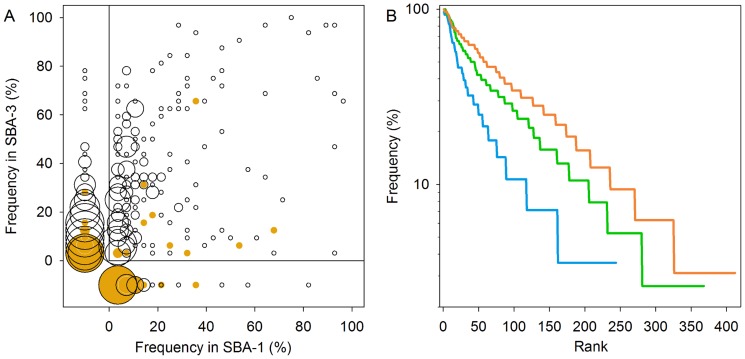
Frequency of occurrence in stand basal area (SBA) classes.Frequency is calculated as the percentage of the plots in which a species occurred with individuals ≥ 1 cm diameter. Species include trees, shrub, palm and lianas. A) A scatter plot of frequencies in SBA class 1 and 3. Open circles give frequencies with ≥ 1 individual (F1) and yellow dots give frequencies with ≥ 5% of total number of individuals (F5%). The size of the circle indicates the number of species with the indicated frequencies (indicated range: from 1 to ≥ 10 species, true range: 1–75 species). Frequencies of species that occurred in one of the SBA classes, but not the other, are plotted to the left or below the null axes. B) Rank-frequency curves, colors indicate SBA-1 (blue), SBA-2 (green) and SBA-3 (orange).